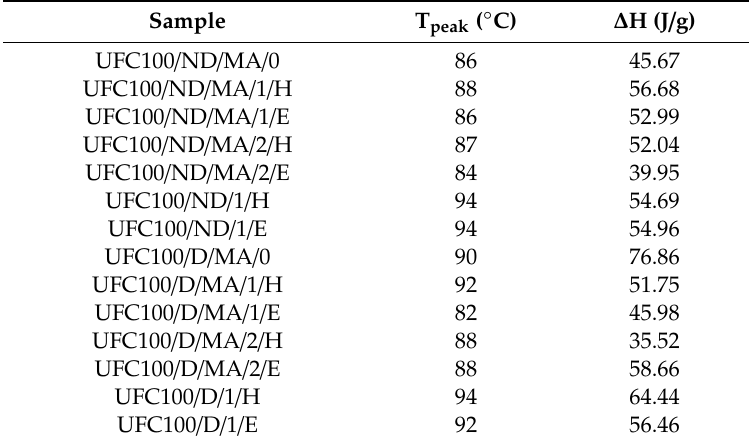
Table 8. Tabularized water evaporation enthalpy values for all modified